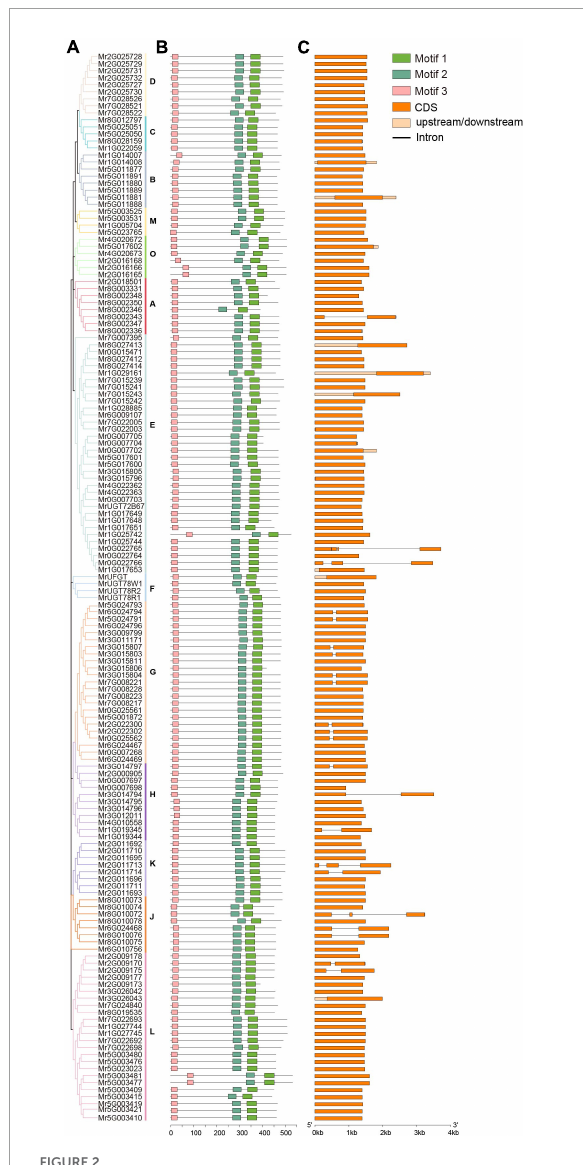
FIGURE2 Analysis of phylogenetic relationship (A) , conserved motif (B) , and gene structure (C) of MrUGT gene family. The 14 groups are shown with different colors. Three conserved motifs were shown with different colors. Orange box represented exons and black lines represented